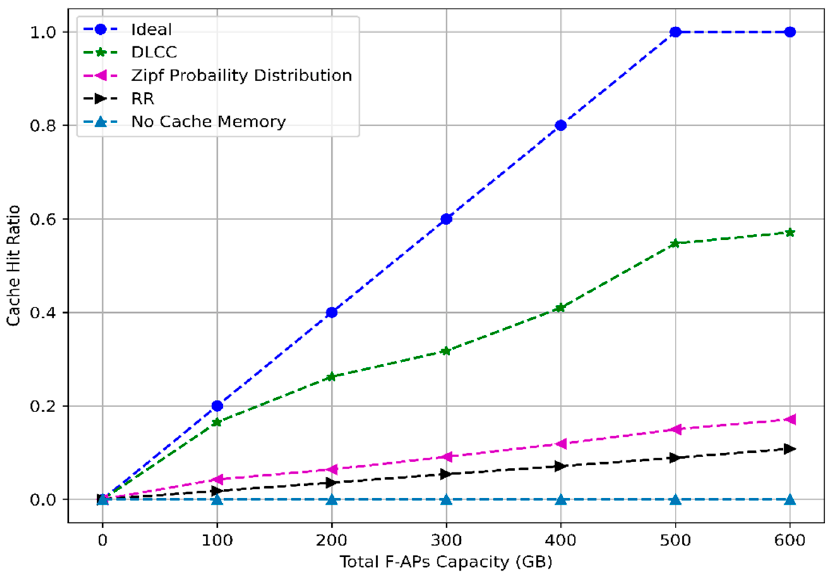
Figure 12. Total F-AP capacity vs. cache hit ratio